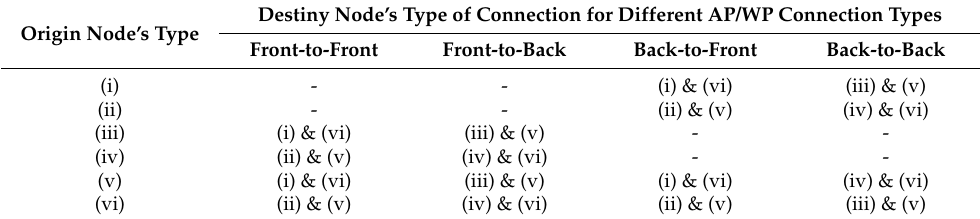
Table 2. TMM’s connection rules for connections between different TM nodes.